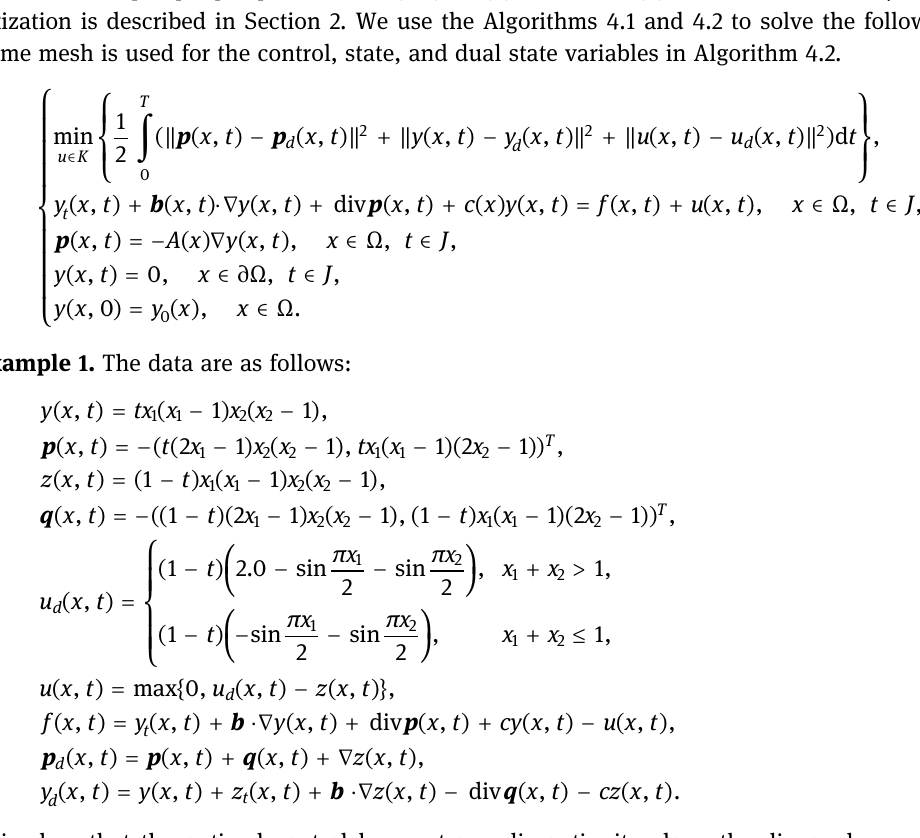
Algorithm 4.2. Adaptive projection gradient algorithm